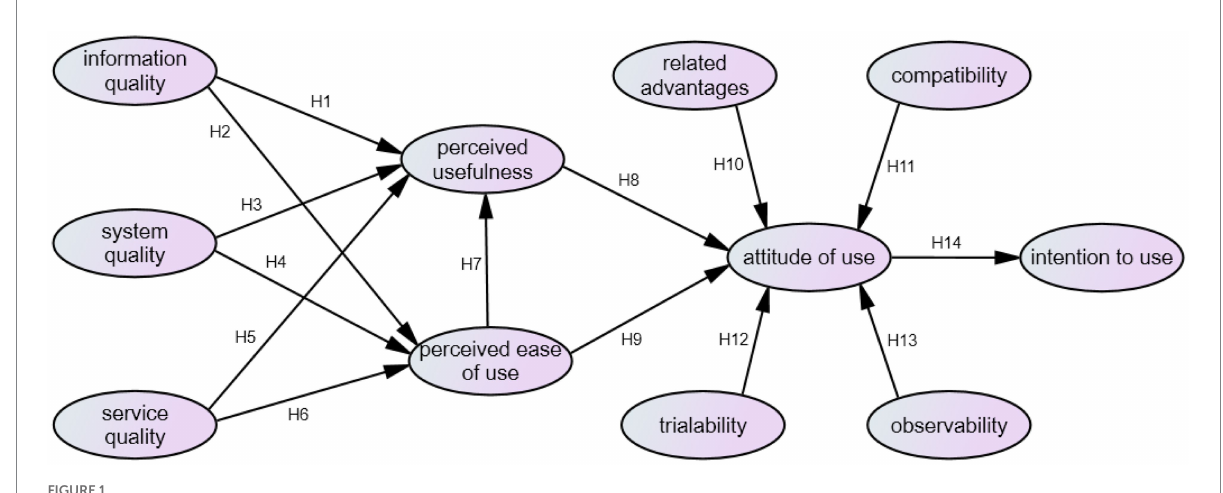
FIGURE 1 Research